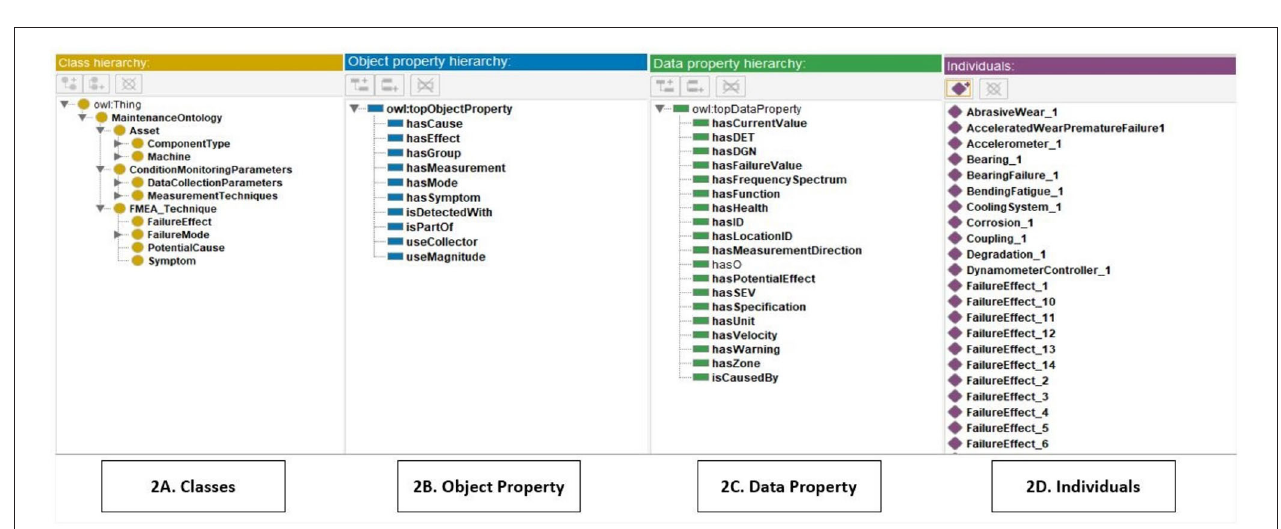
FIGURE 2 | Ontology classes, object property, data property, and individuals. (A) Classes. (B) Object property. (C) Data property. (D)